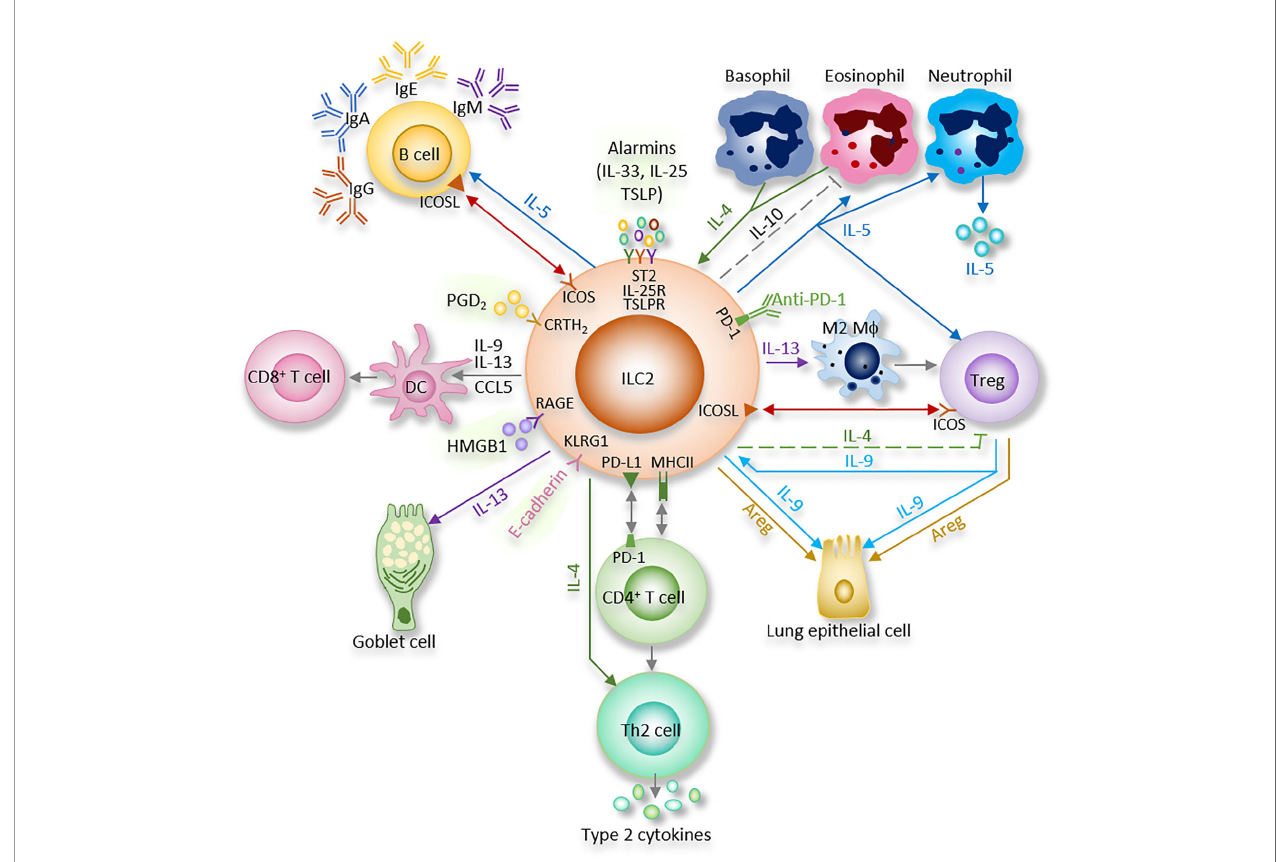
FIGURE 1 | ILC2 interacts with other immune and non-immune cells through a variety of cytokines and cell surface mediators. (1) After activation with alarmins, ILC2 produce type II cytokines and mediators; (2) ILC2 interact with T cells via MHCII, CCL5, PD-1/PD-L1, OX40/OX40L, CD86, CD80, IL-4, IL-5, and IL-13; (3) ILC2 activate B cells to undergo isotype-switching, survival, self-renewal, and secrete antibodies via ICOS/ICOS-L, IL-5; (4) ILC2 stimulate Tregs via IL-5, IL-9, ICOS/ ICOS-L, while ILC2-released IL-4 suppress Tregs. Tregs are capable of inhibiting ILC2; (5) ILC2 prime macrophages into a type 2 immune cell phenotype via IL-13; (6) Epithelial cells derived alarmins activate ILC2. ILC2-released IL-9 and Areg protect lung endothelial cells. (7) ILC2 increase eosinophils via IL-5, HMGB1. ILC2 inhibit eosinophils via IL-10. Eosinophil- or basophil-released IL-4 activate ILC2; (8) ILC2 activate DCs via IL-9, IL-13,